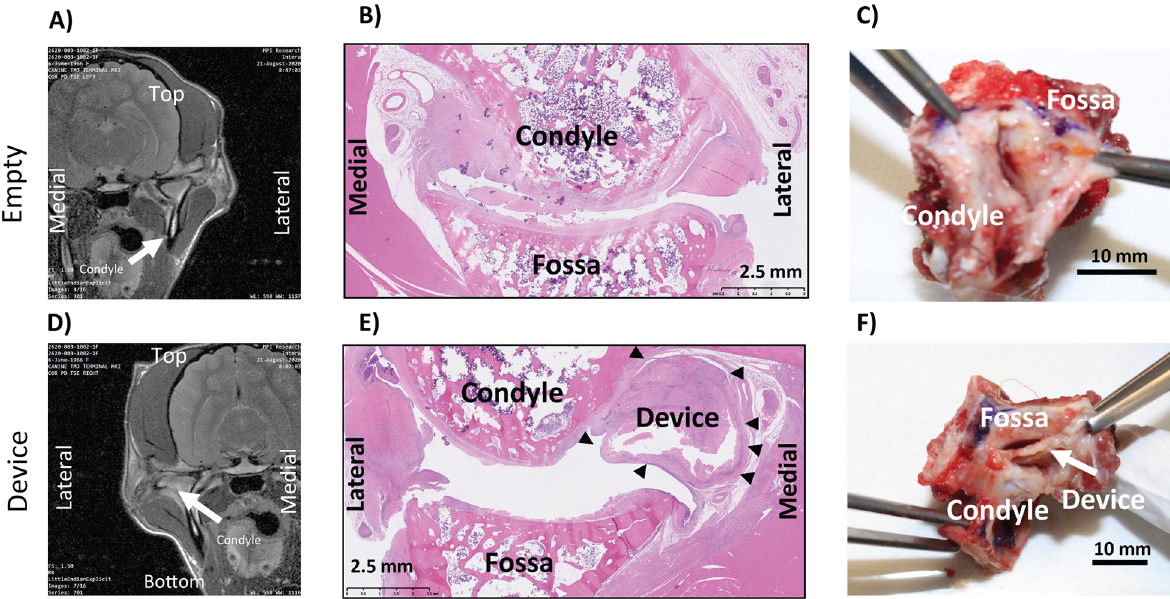
Fig 3. Animal 1002: Coronal MRI of empty (A) and implanted (D), Sagittal H&E of empty (B) and implanted (E), Necropsy Picture of empty (C) and implanted